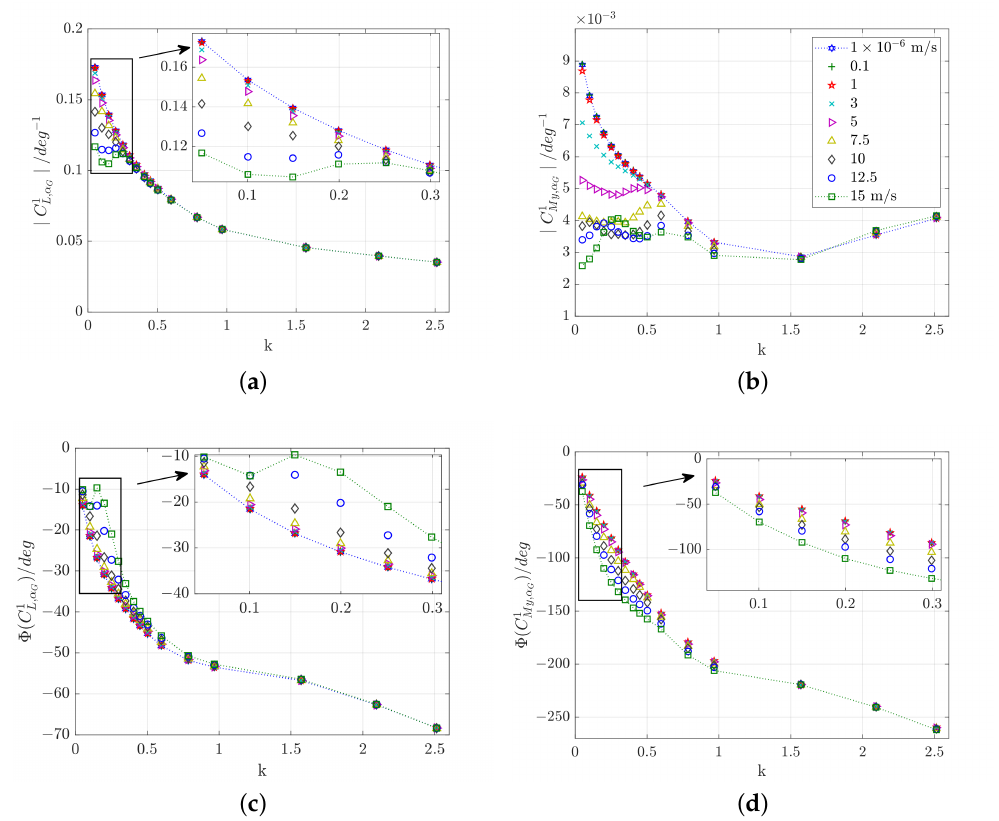
Figure 8. First harmonic of lift and moment frequency response functions (FRFs) for all simulated excitations at Mach 0.70. ( a ) Magnitude of lift first harmonic, ( b ) Magnitude of moment first harmonic, ( c ) Phase of lift first harmonic, ( d ) Phase of moment first harmonic.